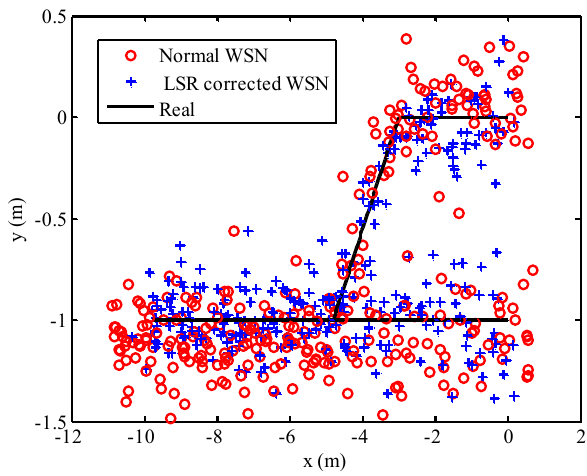
Figure 10. Performance of WSN with LSR correction model.